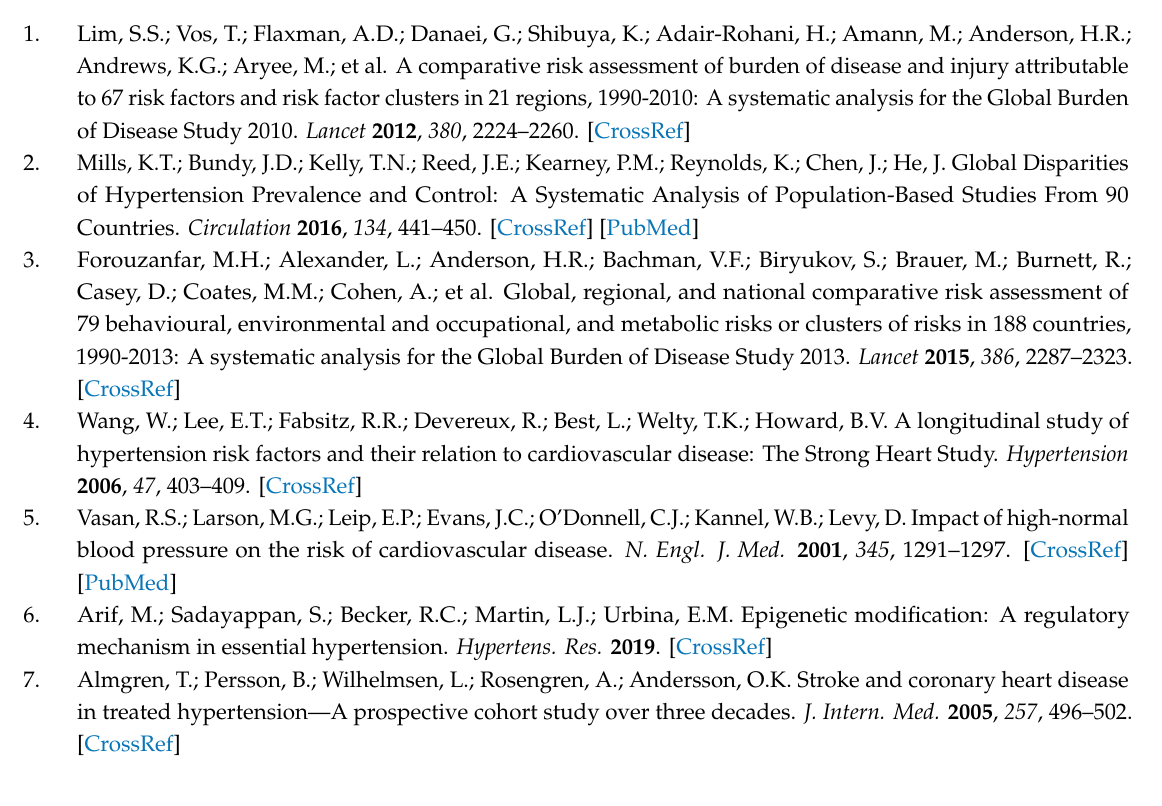
Supplementary Table S1: Primer sequences and PCR